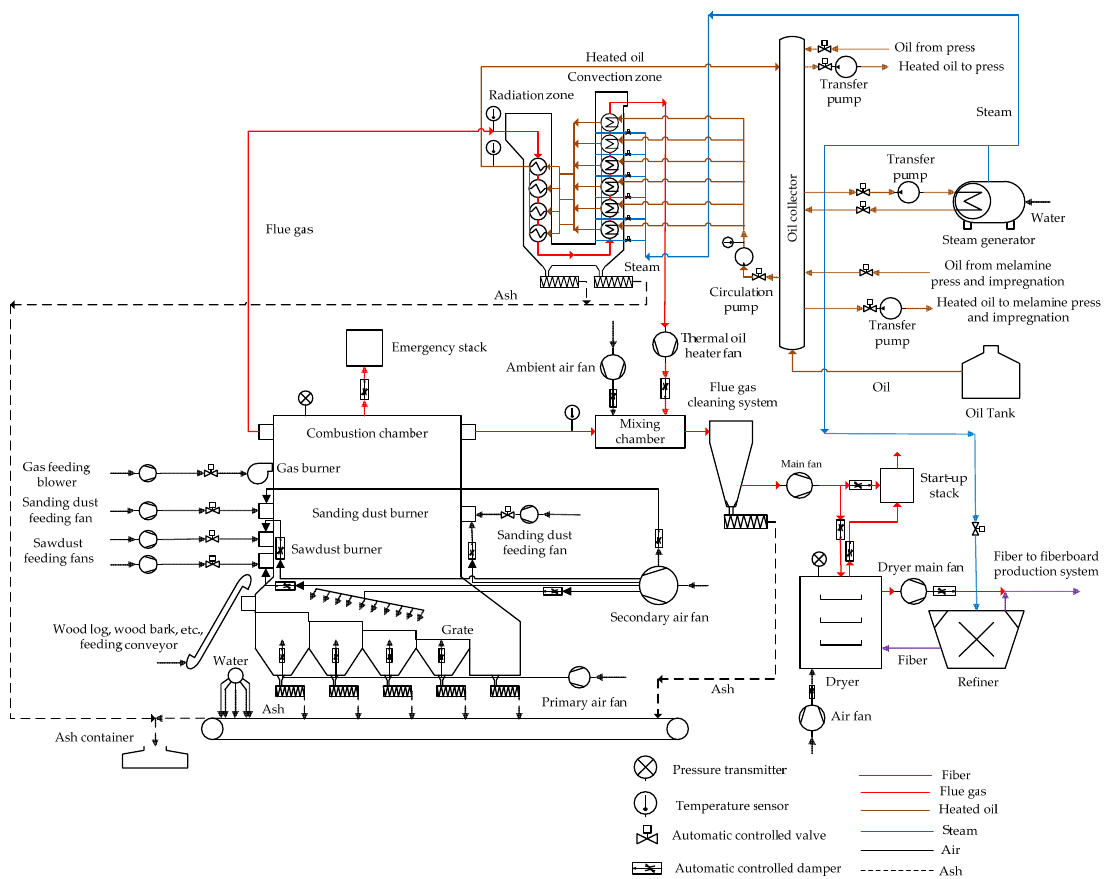
Figure 2. The process diagram of the thermal energy production system in the factory producing furniture components.